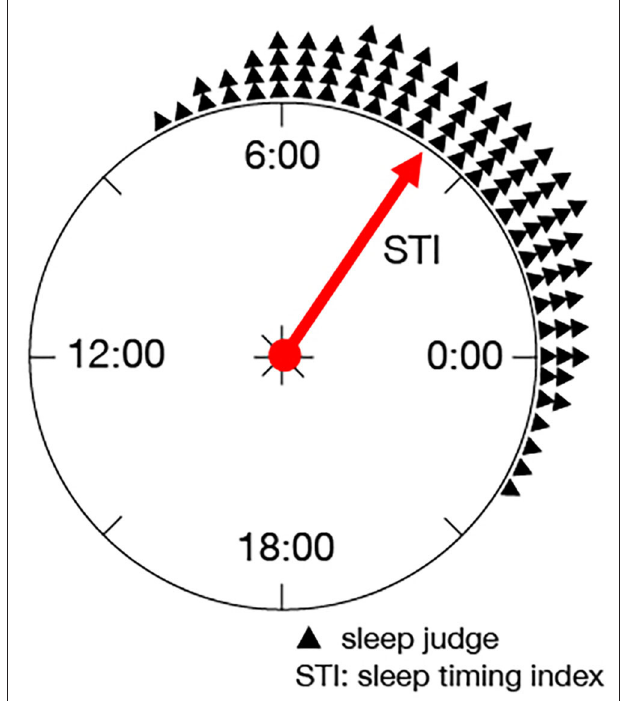
FIGURE 1 | Schematic diagram of STI: STI expresses the mean sleep midpoint during the measurement days as the argument on a unit